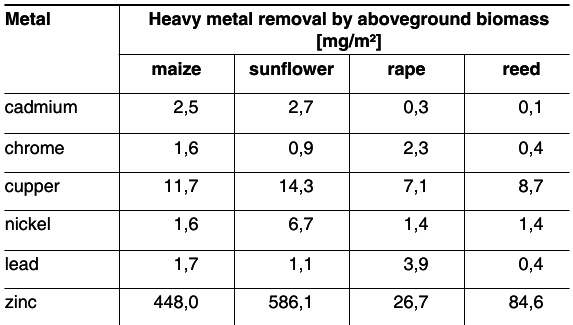
Fig 5. Harvest and disposal of heavy metal-containing biomass Table 1. Heavy metal phytoextraction efficiency: comparison of different plant